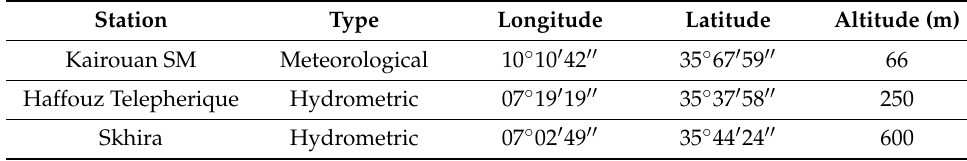
Table 1. Characteristics of stations